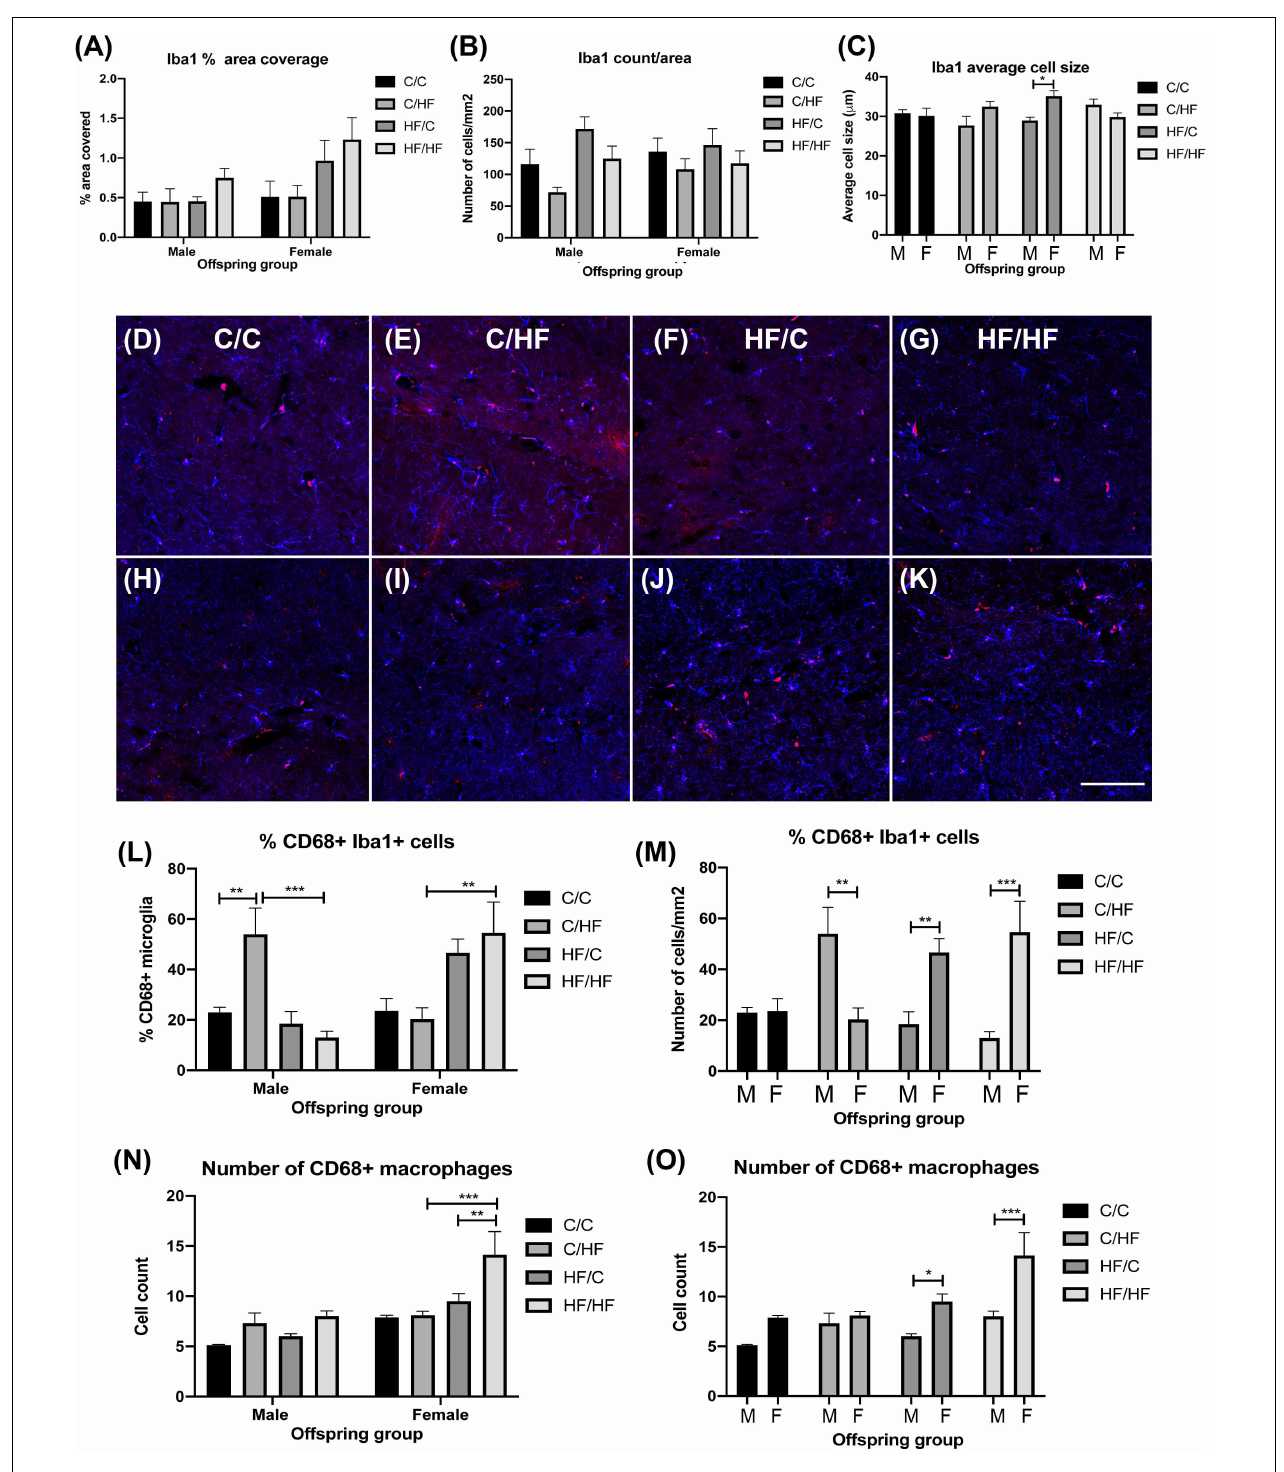
FIGURE 7 | Evaluation of microglia and macrophage expression in the hippocampus of aged male and female offspring. (A–C) Quantification of the percent of hippocampal coverage (A) , cell count (B) and average size (C) of Iba1-positive microglia in 16-month old C/C, C/HF, HF/C and HF/HF mice. (D–K) Photomicrographs of hippocampal tissue sections stained for Iba1 (blue) and CD68 (red) in 16-month old male (D–G) and female (H–K) C/C (D,H) , C/HF (E,I) , HF/C (F,J) and HF/HF (G,K) mice. (L,M) Quantification of the percentage of Iba1-positive microglia that are also positive for CD68 within each diet group (L) and between male and female offspring (M) . (N,O) Quantification of the number of CD68-positive macrophages within each diet group (N) and between male and female offspring (O) . Data represent mean ± SEM. ∗ p < 0.05, ∗∗ p < 0.01, ∗∗∗ p < 0.001, two-way ANOVA with Holm–Sidak post hoc test. Scale bar = 100 µ m.